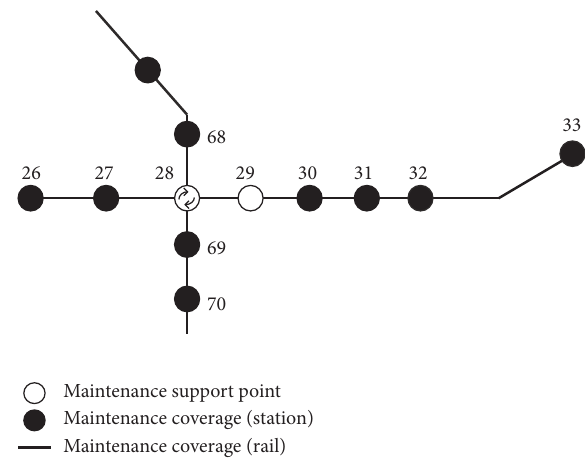
Figure 3: Maintenance support point 29 and its